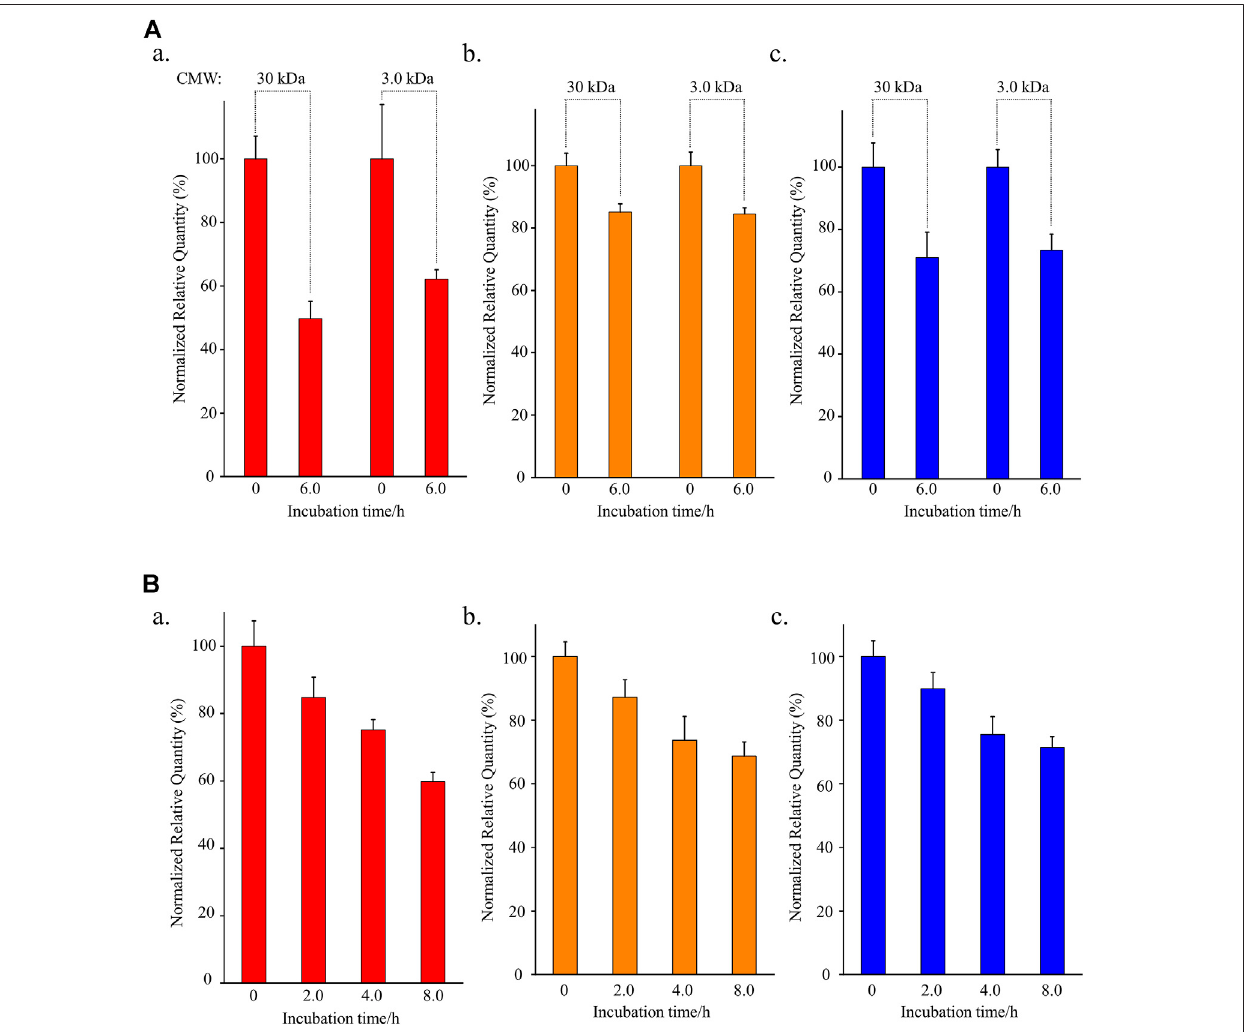
FIGURE2| Investigationofthestabilitiesof(a)osimertinib(red), (b)AZ-5104(orange),and (c)AZ-7550(blue)in (A) fi lteredratplasmaand (B) L-cysteine.In (A) ,the cut-offmolecularweight (CMW) was30 kDaor 3.0 kDa.In (B) ,L-cysteine concentrationwas10.0 μ g/ml.Note: theworkingsolutionsexceptforL-cysteine were keptat 39 ° C for the longest incubation time to eliminate all four chemicals ’ temperature